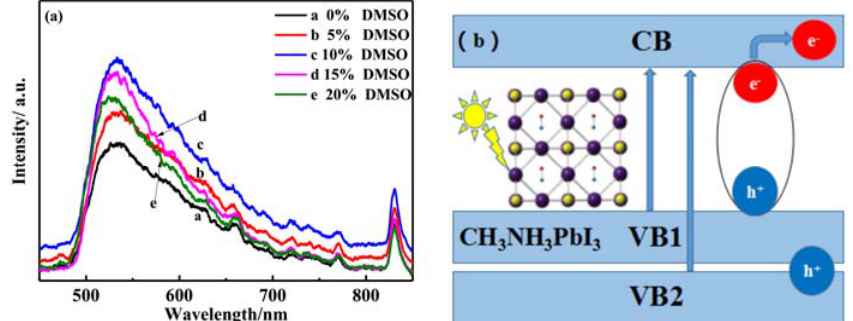
Figure 7. ( a ) Fluorescence emission spectra of perovskite solution precursor (the excitation wavelength was 325 nm); ( b ) The band distribution of the